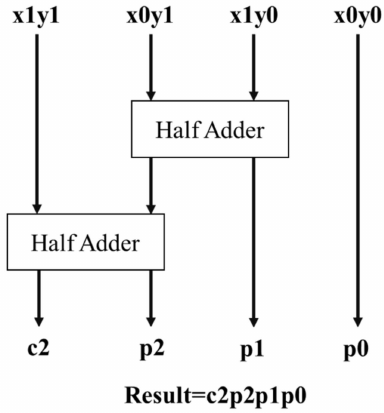
Figure 2. Block Diagram of 2 × 2 Vedic Multiplier.